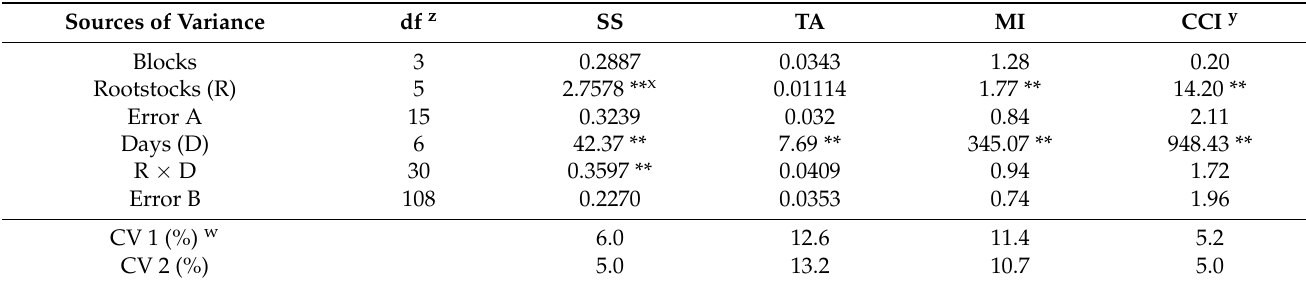
Table 3. Analysis of variance and mean squares of soluble solids (SS), titratable acidity (TA), maturation index (MI) or ratio (SS/TA), and citrus color index (CCI) over time of ‘Valencia’ orange fruits when trees are grafted on different ‘Trifoliata’ hybrid rootstocks at S ã o Sebasti ã o da